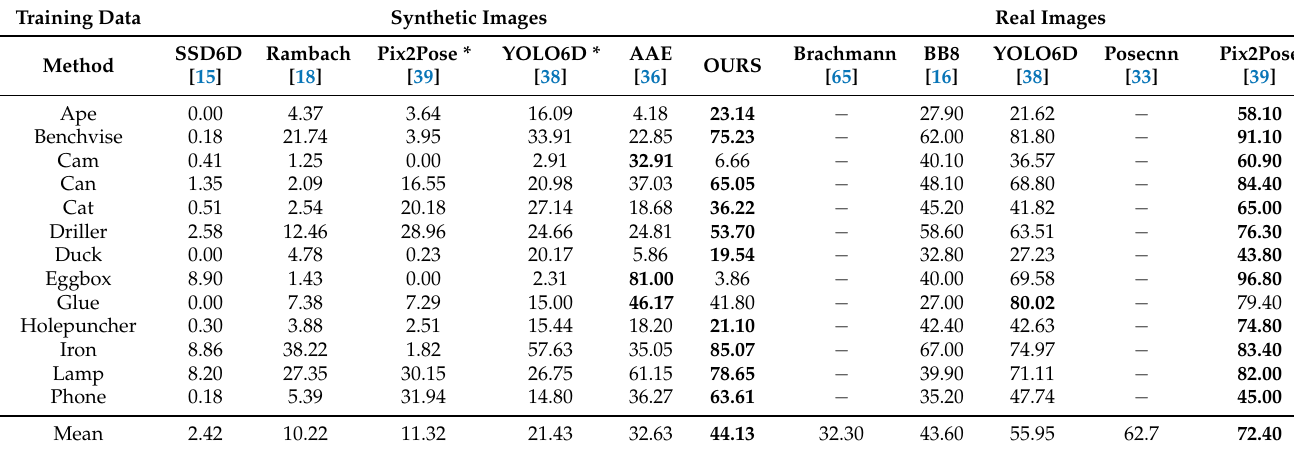
Table 2. Evaluation results on the LINEMOD dataset using the ADD metric with a threshold of 10%, using RGB images only and no pose refinement. Higher is better. *: We trained YOLO6D [38] and Pix2Pose [39] using the same synthetic images as